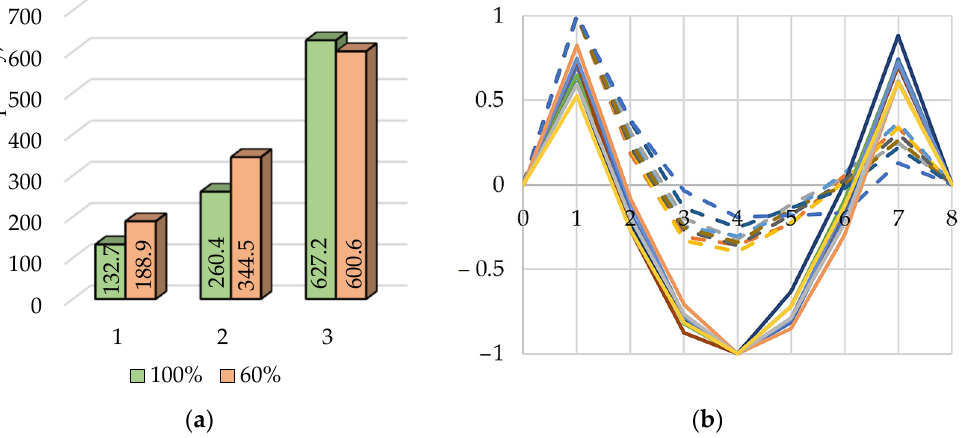
Figure 6. ( a ) The average values of the frequencies for the first three modes, where 100% are without defects and 60% have a 40% large defect; ( b ) normalized 3rd mode shapes for specimens without defects (continuous lines) and with defect (dashed lines).